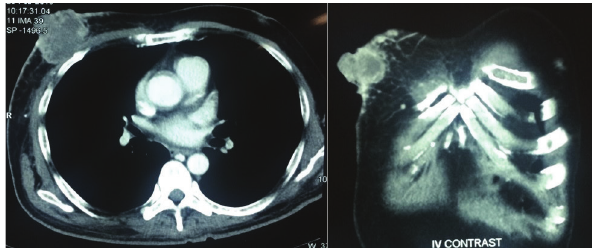
Figure 2: CECT of chest suggestive of breast carcinoma with erosion of 4 th rib